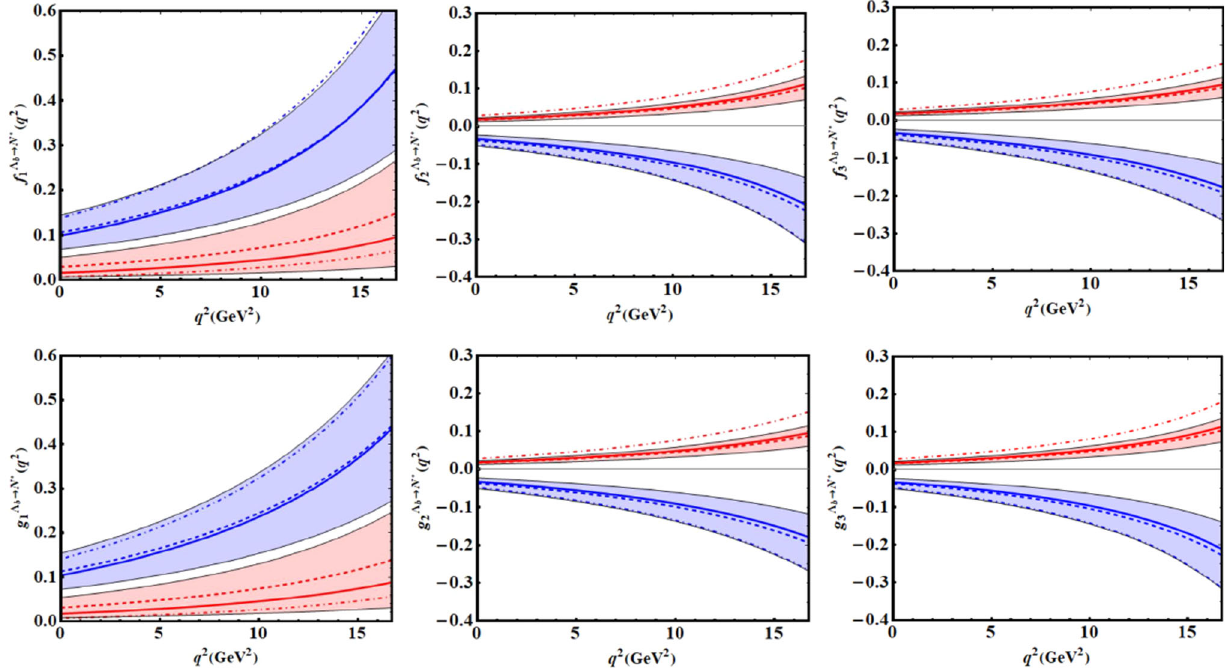
Fig. 3 Same as Fig.2 but for (cid:2) b → N ∗ transition form